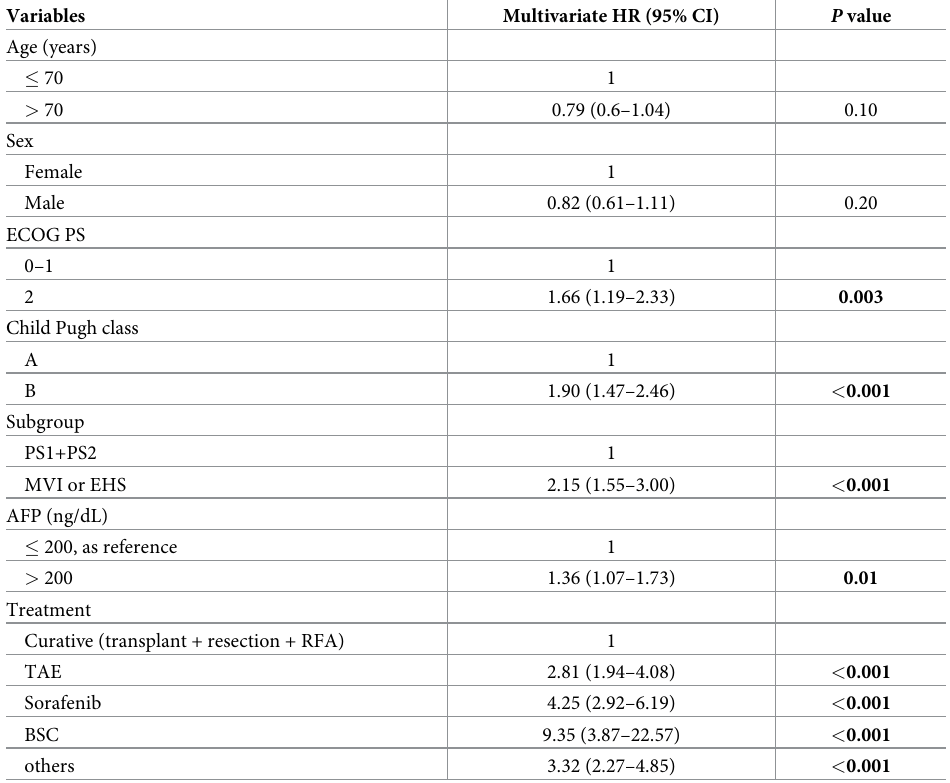
Table 4. Independent risk factors for mortality in patients with advanced HCC (multivariate regression